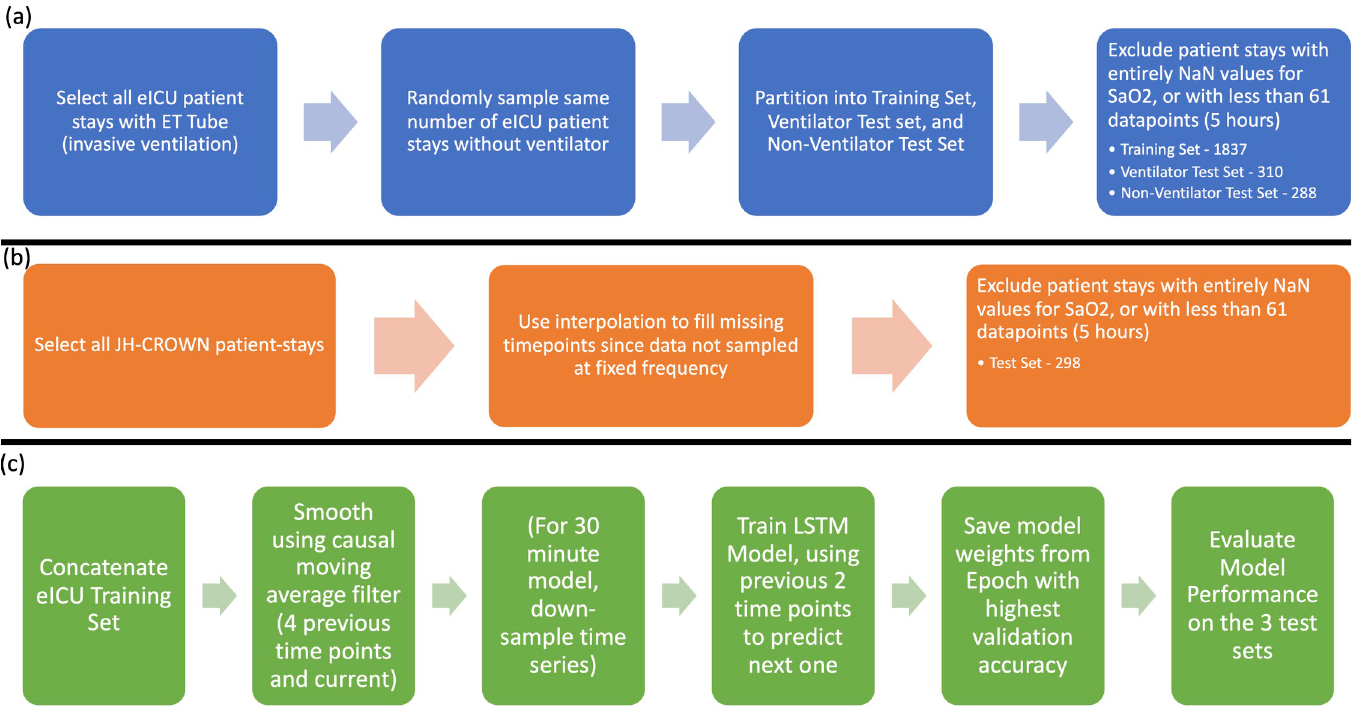
Fig 1. Schematic illustrating data processing for (a) eICU patients and (b) JH-CROWN patients, and (c) model training and testing pipelines.